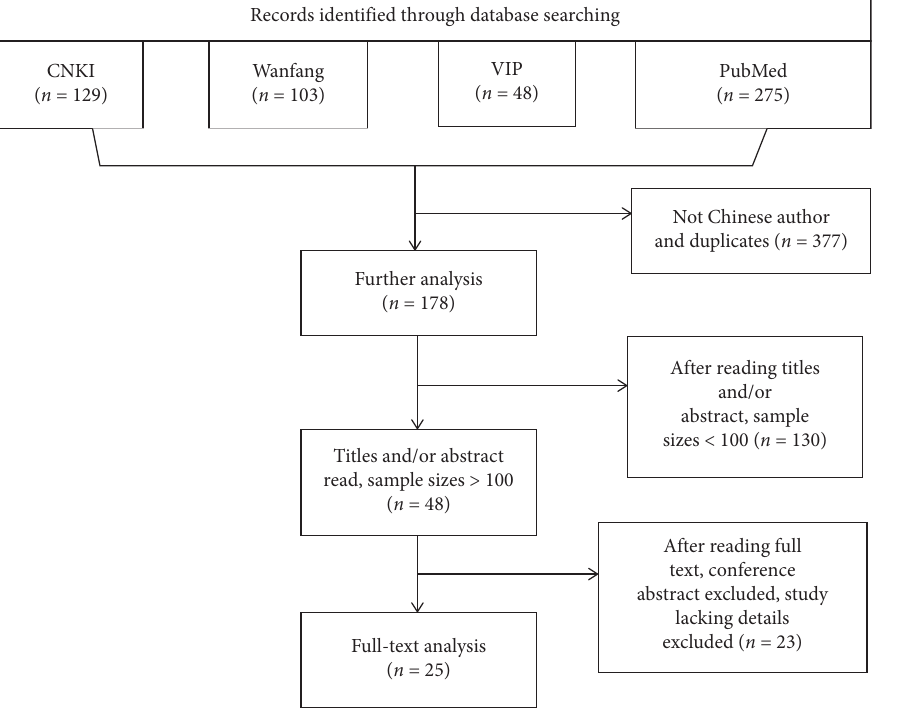
Figure 1: Flow diagram of study